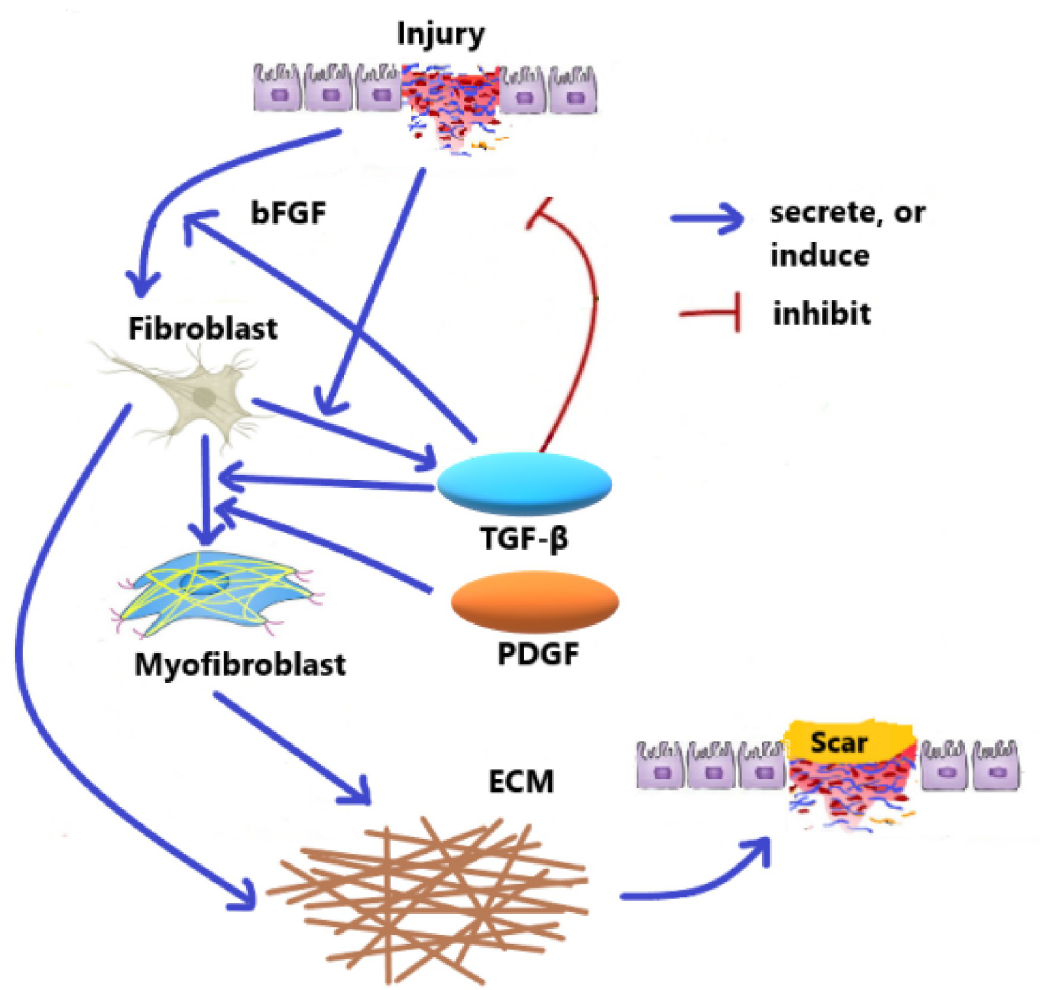
Fig 1. Part of schematic network of cells and proteins in IPF. When the tissue is damaged, the immune system secretes inflammatory mediators such as TGF- β and PDGF, which cause myofibroblasts to be active to transfer fibroblasts. Finally, collagen formation takes place in the ECM tissue. The damaged tissue repair. Fibrosis occurs when this repair is